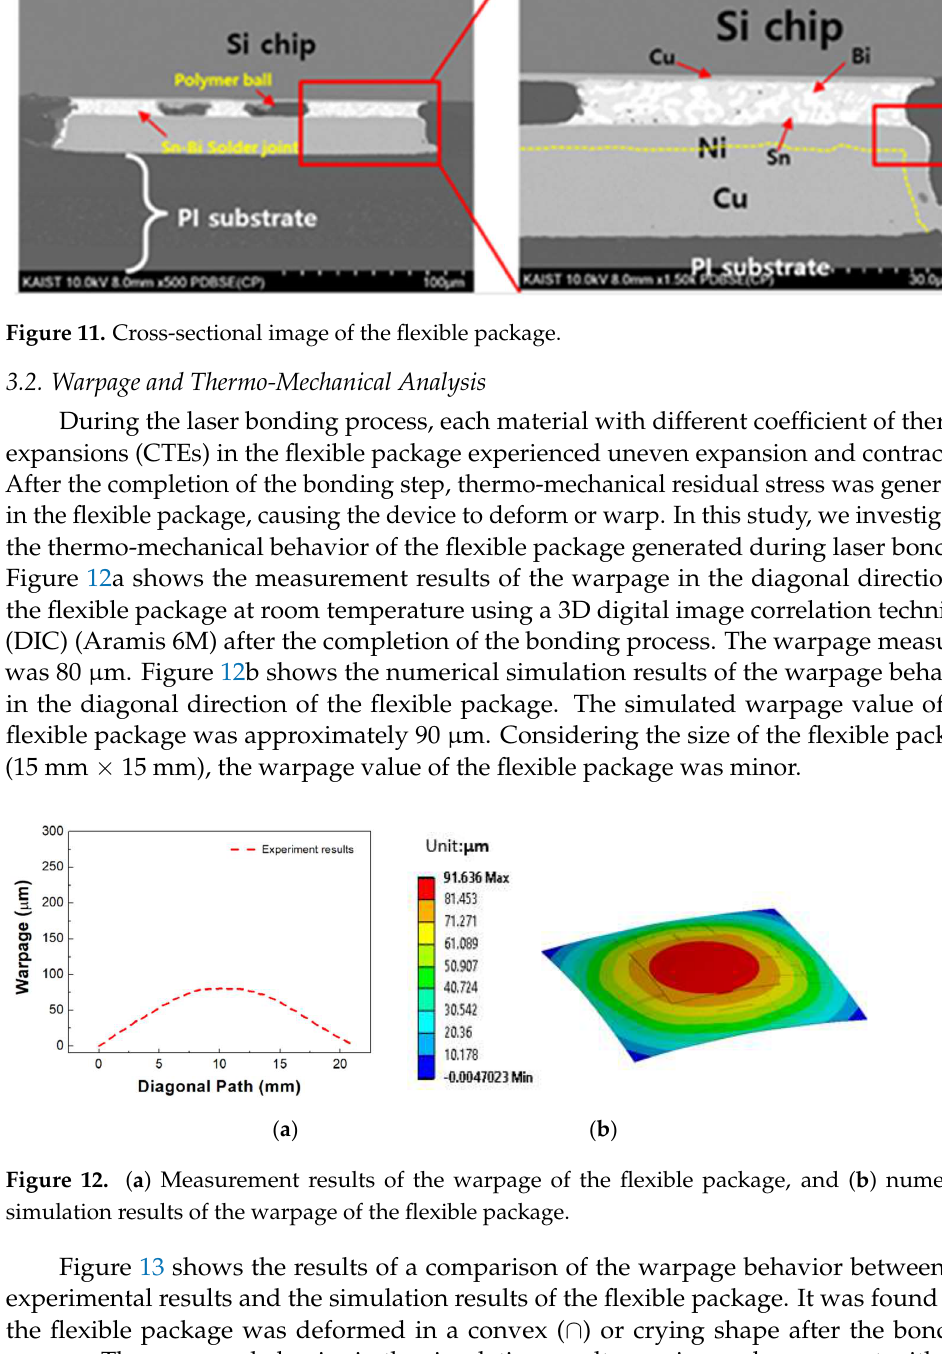
Figure 13. Comparison of the warpage of the flexible packaging between the experimental results and the simulation results. During the laser bonding process, the components most vulnerable to residual stress were the brittle silicon chip and the interconnection region. Figure 14 shows the simula- tion results in the form of a stress distribution map of the silicon chip. The simulated max- imum stress of the silicon chip was around 41 MPa. The maximum strain subjected to the silicon chip was 0.019%. This strain value was very small compared to the fracture strain of the silicon material (0.8%) [27], meaning that there was no chance for cracks or damage to arise during the laser bonding process. Figure 15 shows the simulated von Mises stress distribution of the solder joint region generated during the laser bonding process. The maximum stress occurred at the top edge of the solder, which was near the interface be- tween the solder and the silicon chip. The maximum stress of the solder was 1.8 MPa, which was very low. The yield strength of the solder was around 70 MPa; so, there was no plastic deformation or failure of the solder material during the laser process. The solder was, therefore, well formed and showed good bonding after the laser bonding process.